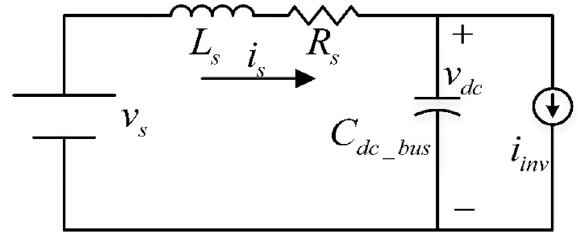
Figure 2. Source/Inverter/Load equivalent